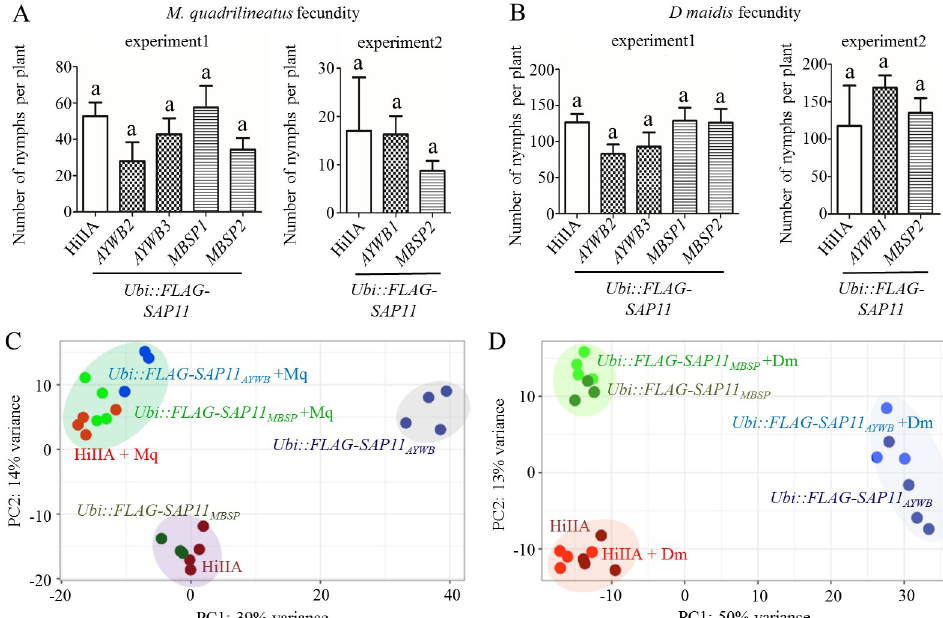
Fig 7. The phytoplasma SAP11 AYWB and SAP11 MBSP effectors do not modulate maize defences in response to exposure to AYWB and MBSP leafhopper vectors M . quadrilineatus and D . maidis , respectively. (A, B) Numbers of nymphs produced from the two leafhopper species are similar among SAP11 transgenic and WT maize lines. AYWB1, 2 and 3 and MBSP1 and 2 indicate independent transgenic lines. a above the error bars indicates no significant differences (one-way ANOVA with Tukey´s Multiple Comparison Test, n = 4). (C) M . quadrilineatus exposure (+Mq) similarly alters gene expression of SAP11 AYWB and SAP11 MBSP transgenic and WT maize lines. (D) Gene expression patterns of D . maidis- exposed (+Dm) transgenic and WT maize lines are similar to those of non-exposed lines. (C, D) Principal component analysis (PCA) on the matrix of normalized read counts of 6 treatments (n = 3–4 per treatment, see S5 and S6 Tables). RNA-seq experiments were done with Ubi :: FLAG-SAP11 line 1 and Ubi :: FLAG-SAP11 AYWB MBSP line